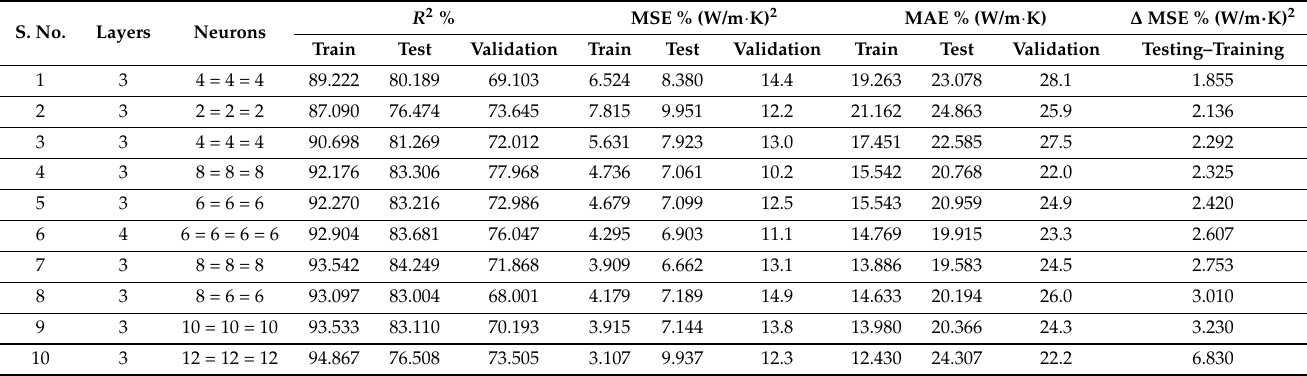
Table 3. Training, testing and validation results considering Network - III .